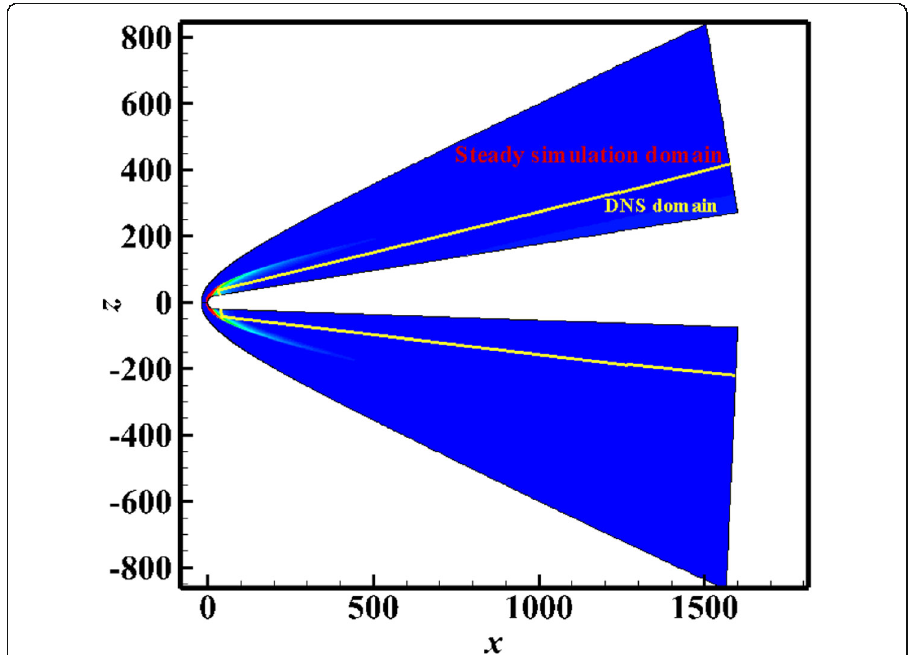
Fig. 3 Schematic diagram of DNS calculation domain (symmetric